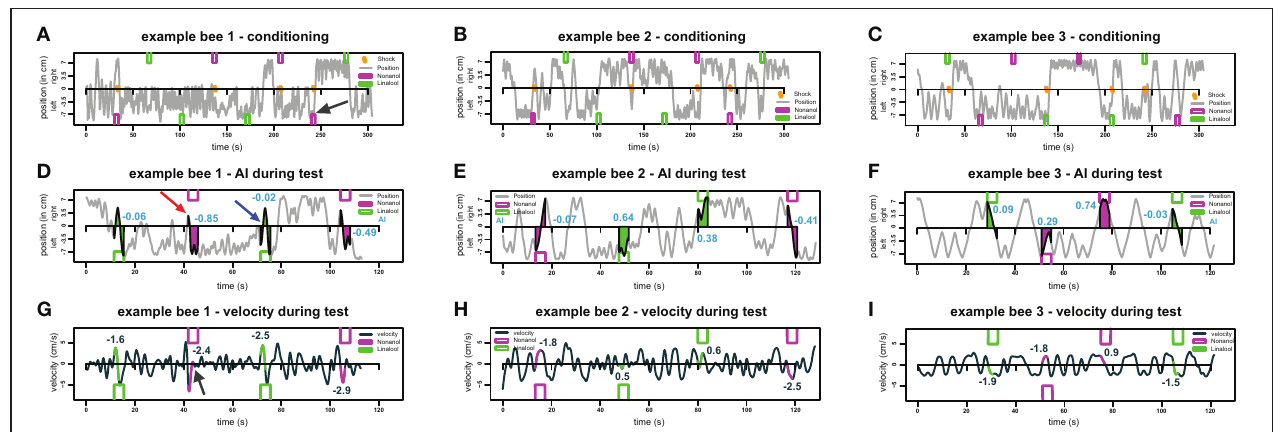
FIGURE A2 | Example traces for three different bees. (A–C) Example movement traces for three different bees during the training phase. Bees moved in the conditioning chamber from left end ( − 7 . 4cm) to right end ( + 7.4cm). Green and magenta boxes indicate odor stimuli for linalool and nonanol, respectively. Orange zigzag lines indicate shock stimuli, the black arrow in (A) indicates an example response of a bee to shock: at the onset of the odor-shock-pairing, the bee oscillates on the left side and then escapes to the opposite side. (D–F) Movement of the same bee as in (A–C) during test phase. As in (A–C) , green and magenta boxes indicate odor stimuli for linalool and nonanol, respectively. AI is visualized by the colored polygons, and the